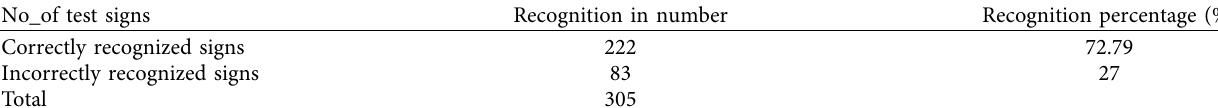
Figure 11: Train_acc and Val_acc Vs Train_loss and Val_loss for ResNet50. Table 3: Results on the number of recognized images using EfficientNetB0 and ResNet50 models.